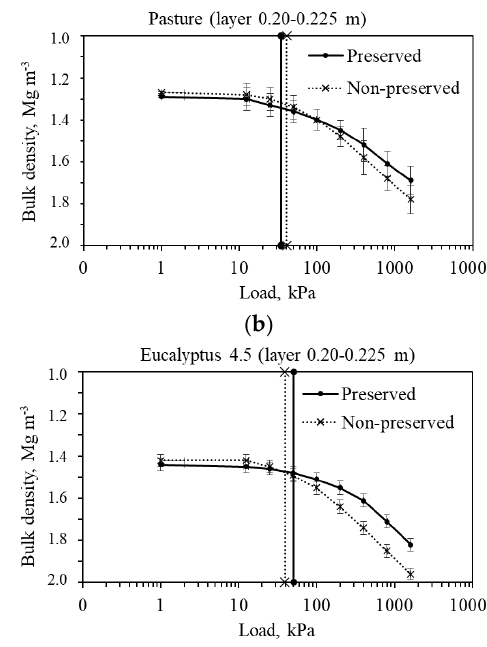
Figure 4. Soil compression curve for soil with preserved and non-preserved structure in the 0.20 – 0.225 m soil layer for four land uses. Vertical error bars for each pressure indicate the least significance difference, while vertical bars that accompany the superior and inferior axes in the figure indicate the precompression stress value for the preserved and non-preserved soil